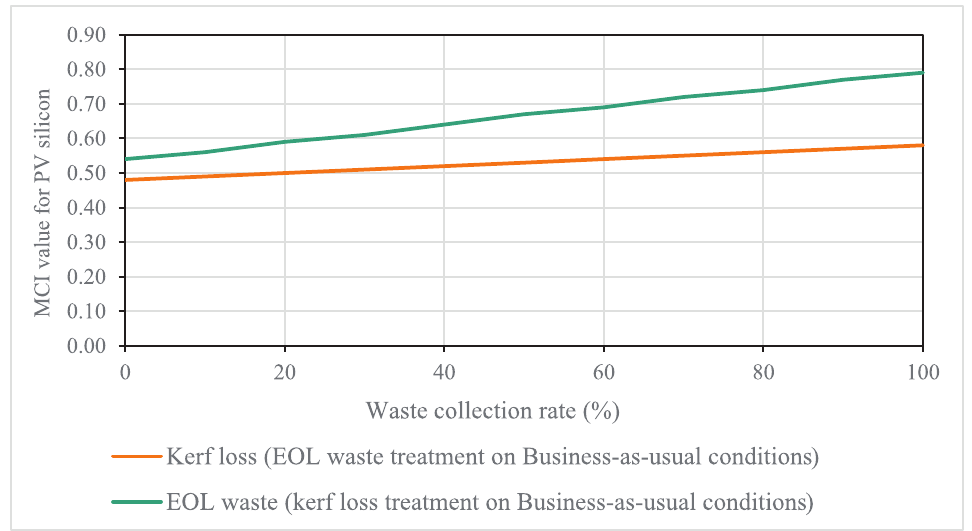
Fig. 5. PV module waste collection rate effect on the MCI score of silicon within the PV